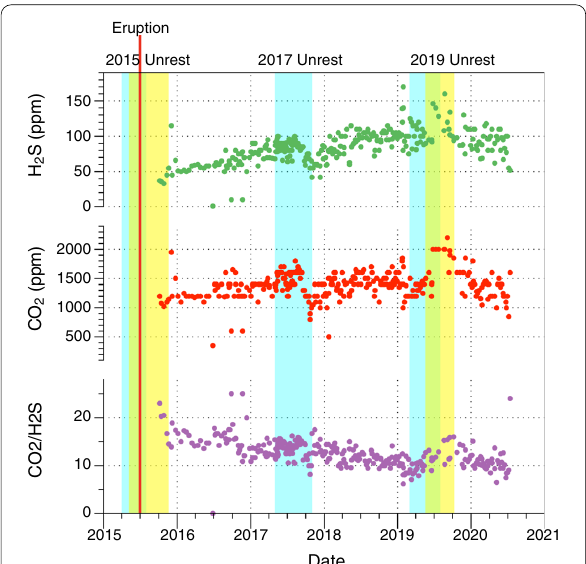
Fig. 9 Sequential change in the volcanic component of soil gas near the center of the 2015 eruption (Loc. 3 in Fig. 1c). The soil gas concentrations were measured by detector tubes. No pressure correction was applied. The durations of volcanic unrest episodes are shown as shaded yellow (VAL2 or more) and blue (baseline across the volcano is increasing). See caption of Fig. 3 for